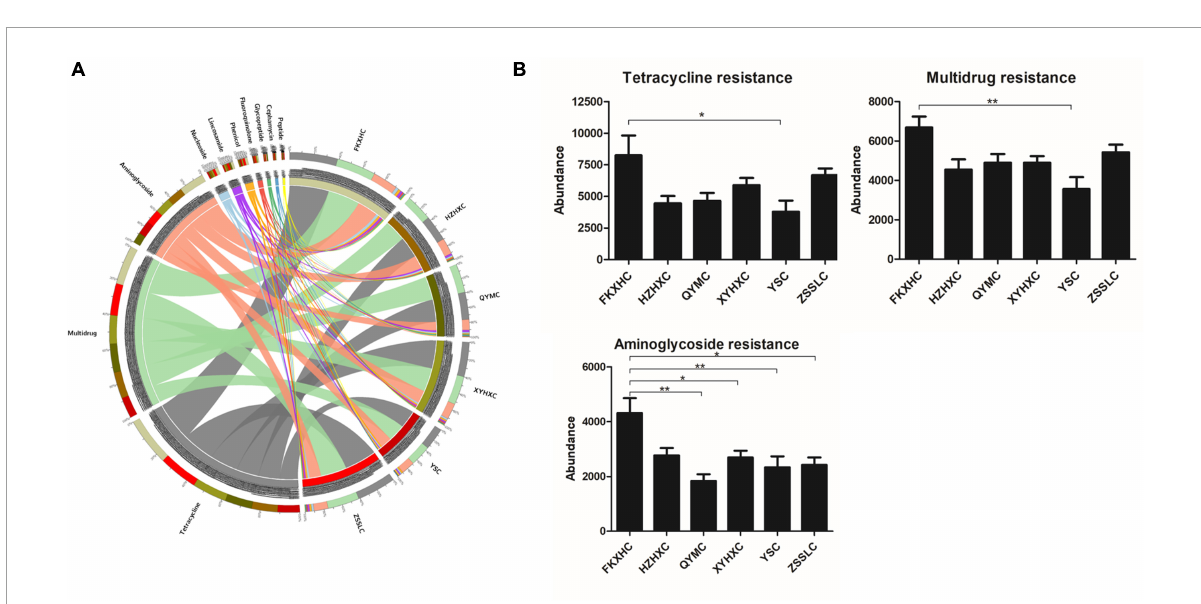
FIGURE6 The abundance of antibiotic resistant types. (A) Circos plot of relative abundance of ARG types, right side of the circle indicates group information, left side indicates antibiotic information, outer circle is the ideogram scale of distribution of unique genes, and inner circle represents different groups. (B) Histogram showing the difference abundance in the resistance types among the six groups. Data are expressed as means ± SEM, * p < 0.05; ** p <